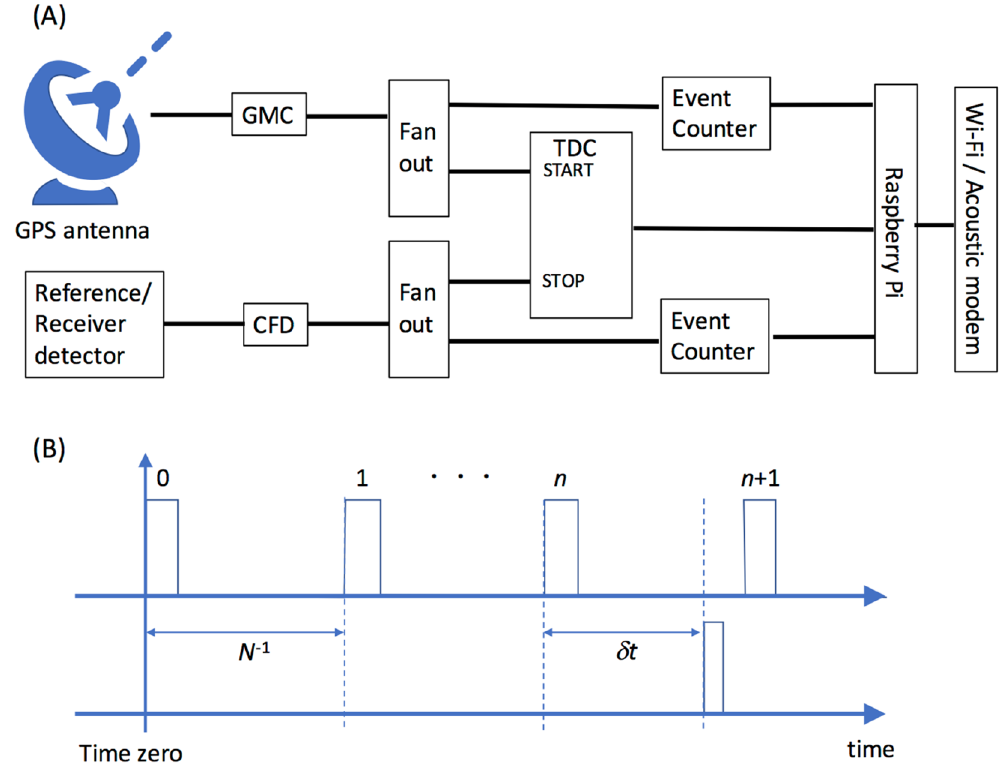
Figure 2. Block diagram of the current wireless muometric positioning/navigation system (MuWMS) ( A ). Both reference detectors and receiver detectors are initially connected with a GPS antenna, but the receiver detectors will be eventually disconnected from the GPS signals when entering indoor/underground/underwater regions. The time series of the logic levels output from the GMC (top) and those output from the TDC (bottom) are illustrated in ( B ). "Time zero" indicates the moment the reference signal is sent to the event counters. N −1 is the GMC signal output period that usually ranges from 10 to 100 ns. δt is the time difference between the GMC signal pulse input and the TDC signal pulse